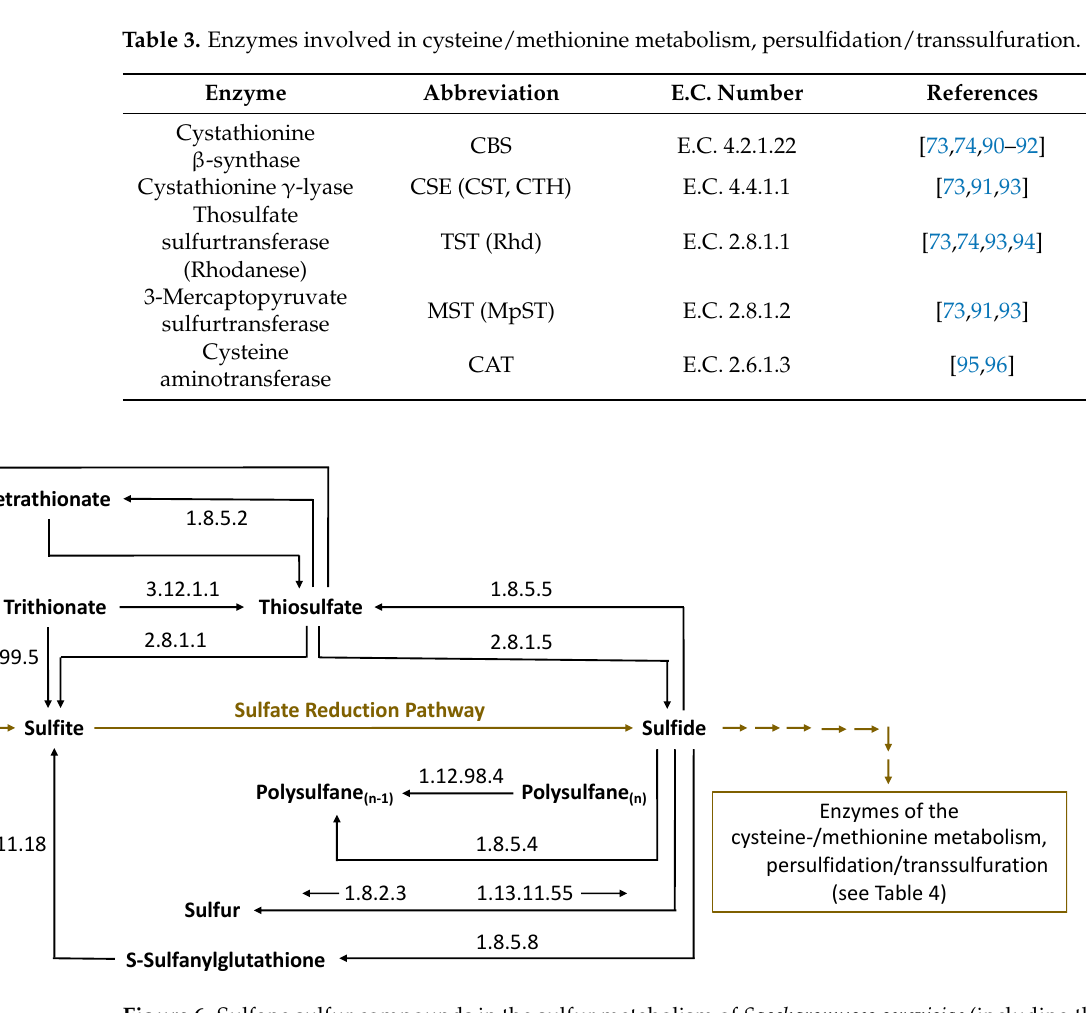
Table 4. Enzymes for sulfur metabolism involved in the transformation of sulfane sulfur com- pounds (selected from KEGG [89] (sulfur metabolism of Saccharomyces cerevisiae )). Sulfane Sulfur Compound